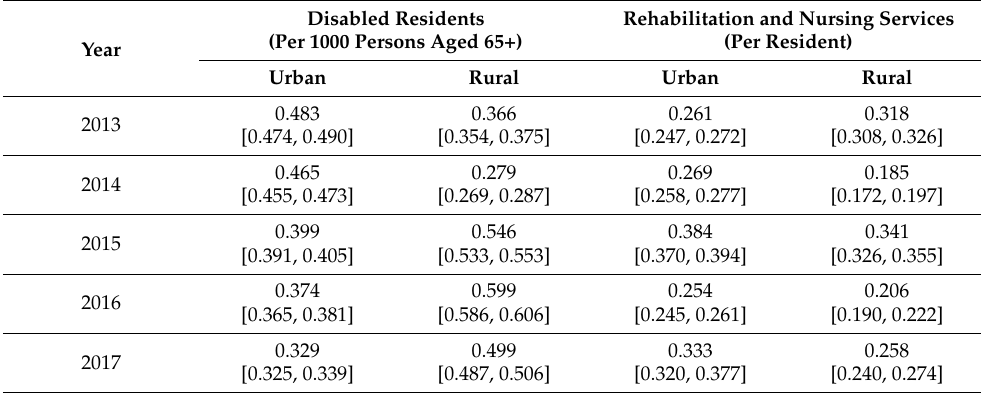
Table 6. CIs for LTC resources and services